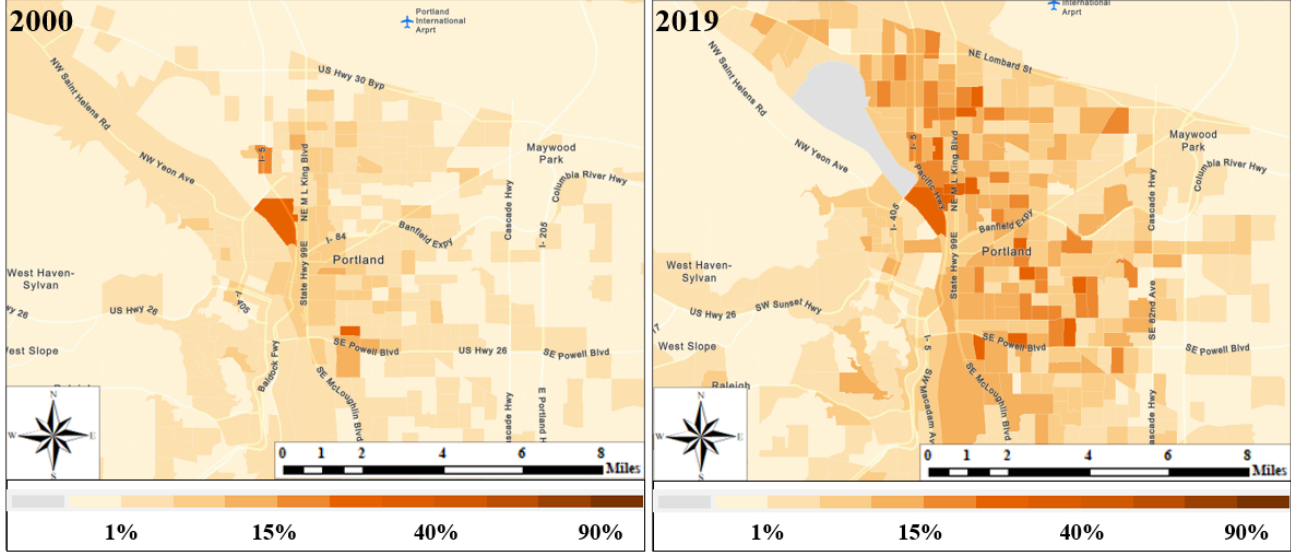
Figure 1. Use of bicycles for commuting for workers aged 16 years and over. Prepared by Social Explorer (accessed on 10 June 2022).